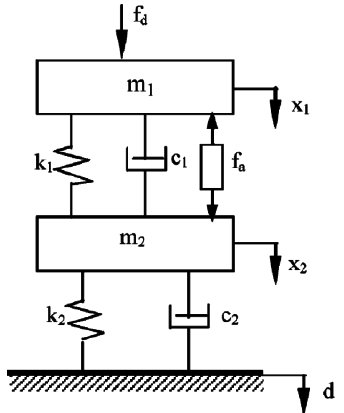
Figure 2. Dynamic model of the bionic vibration isolation system [42].